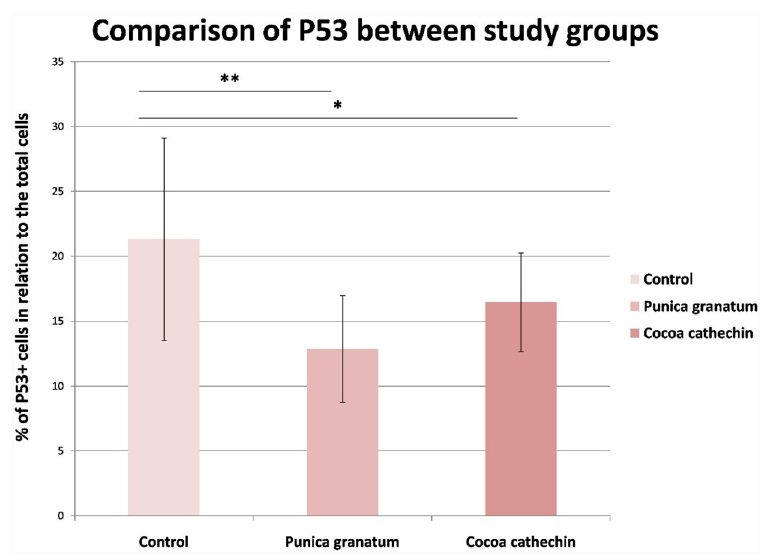
Fig 4. Comparison of percentage of P53 immunohistochemical positive cells in relation to the total number of cells between study groups (Tukey test). Significant difference ( � p � 0.050; �� p < 0.010).